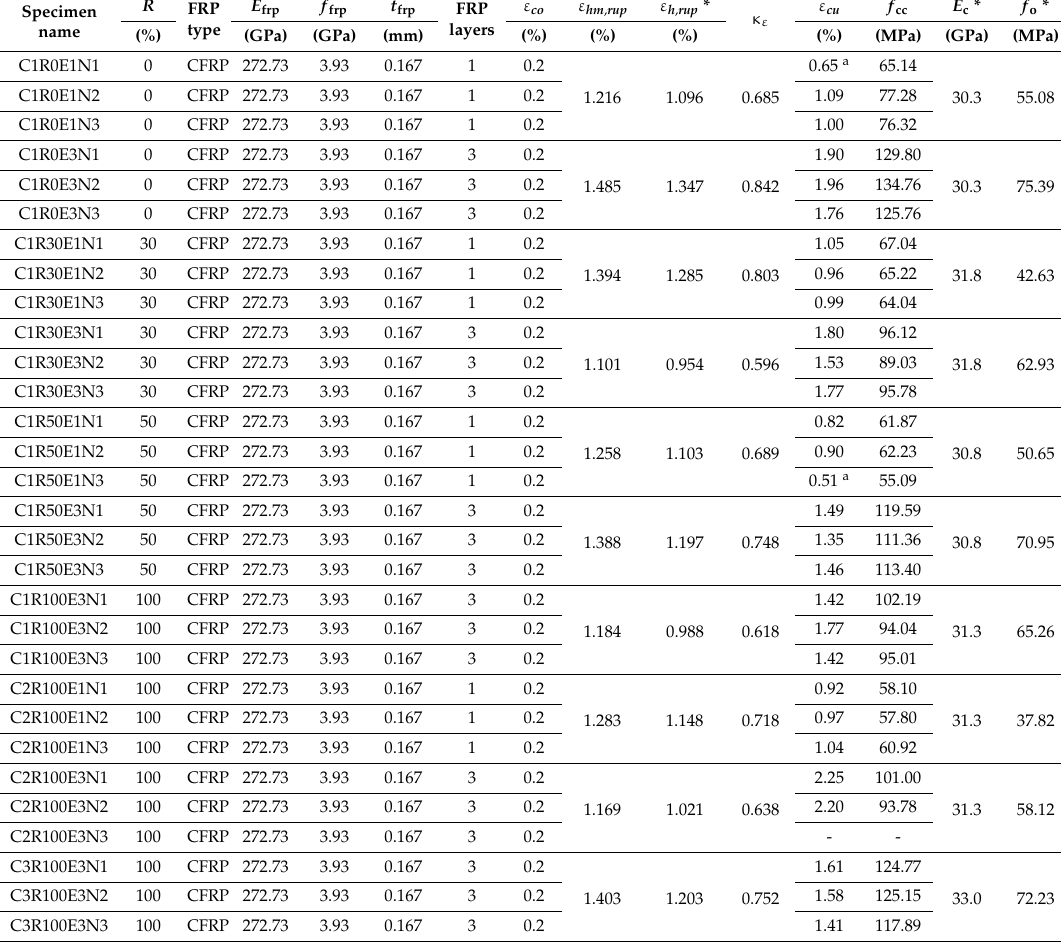
Table 4. The key experimental results of CFRP (carbon fiber-reinforced polymer)-confined